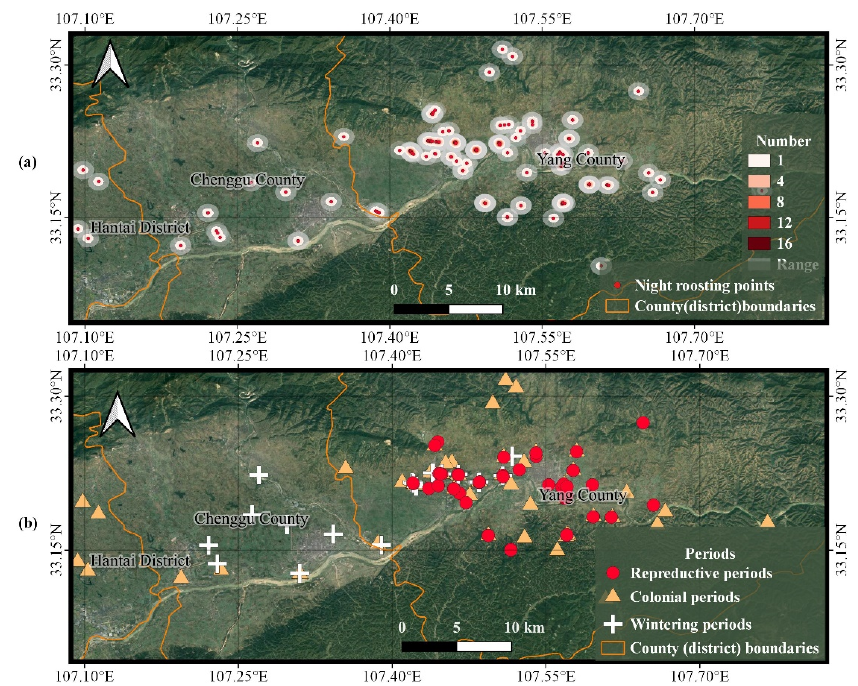
Figure 5. ( a ) Night roosting points in Hantai District, Chenggu County, and Yang County. ( b ) Dis- tribution of activity periods at night roosting points. ( a ) The gray areas indicate the extent of their night roosting points. The darker the red, the greater the number of night roosting points. ( b ) The reproductive period lasts from February to June, the colonial period from July to October, and the wintering period from November to January.